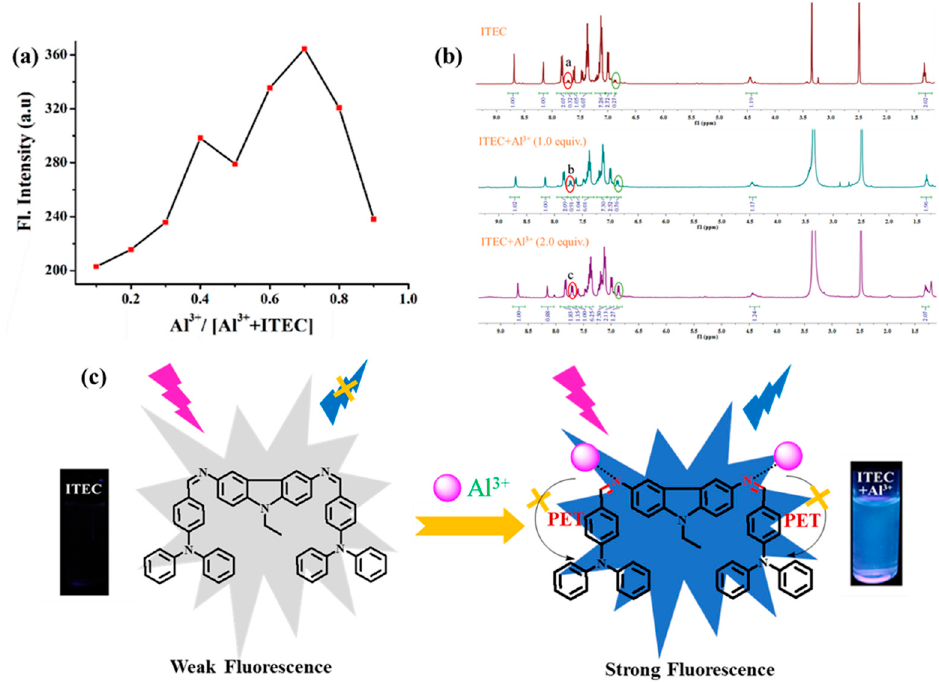
Figure 4. ( a ) The Job’s plot for ITEC-Al 3+ complex, [ITEC] + [Al 3+ ] = 10 μ M; ( b ) 1 H NMR (400 MHz) spectra of ITEC, ITEC with Al 3+ (1.0 equiv.), and ITEC with Al 3+ (2.0 equiv.) in DMSO; ( c ) The proposed binding mechanism of ITEC-Al 3+ and the color change of ITEC solution (20 μ M) after adding Al 3+ (40 μ